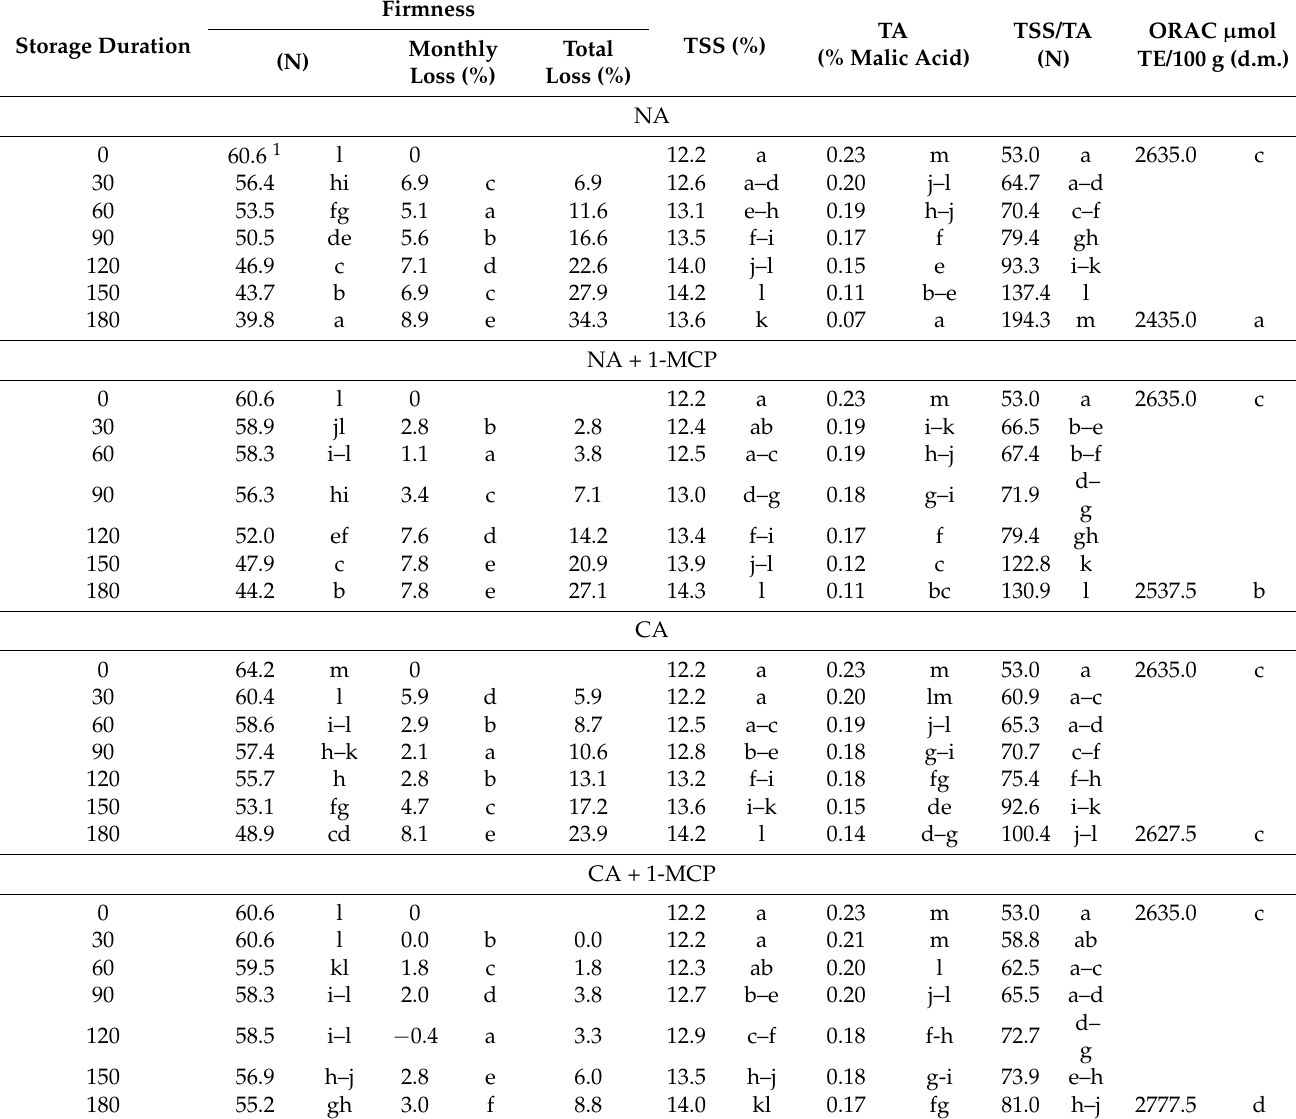
Table 6. Effect of storage technology on the quality parameters of pears in 2012.